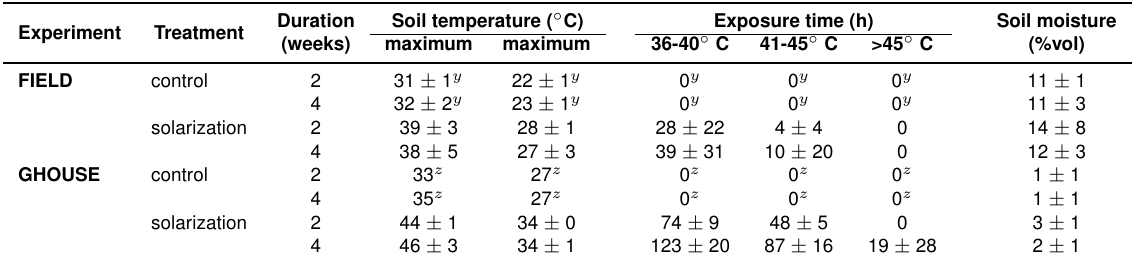
Temperatures were measured at 10 cm soil depth and means calculated across four replicates unless otherwise noted: y data from 3 replicates; z data from one replicate. Soil moisture was measured in three locations per plot at plastic termination.